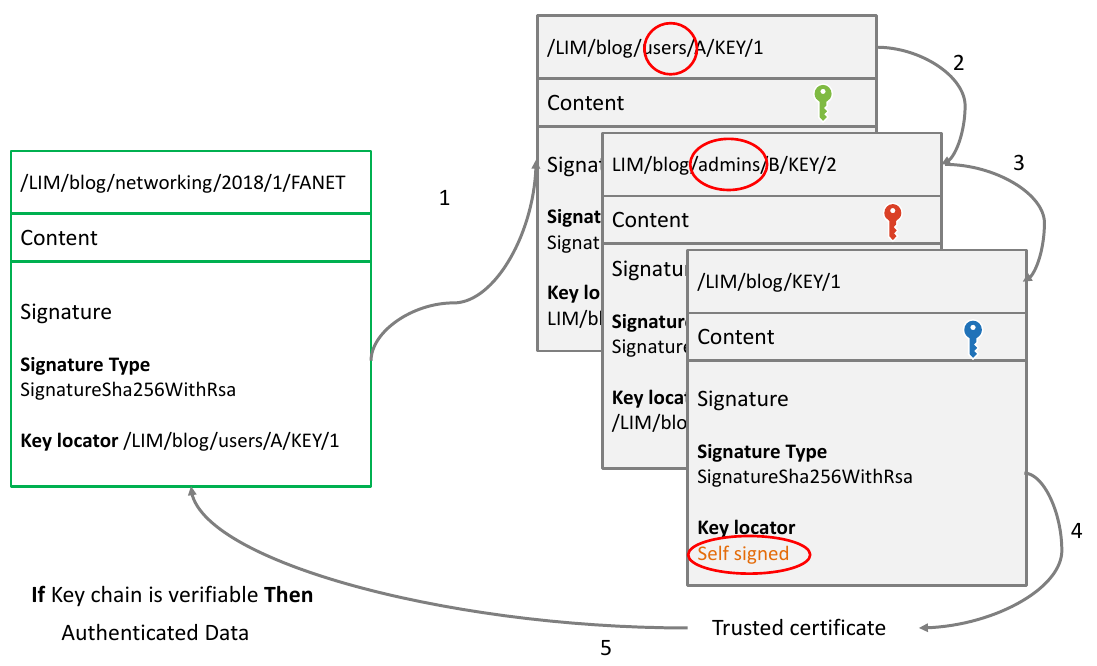
Figure 2. Vanilla NDN hierarchical data authentication process